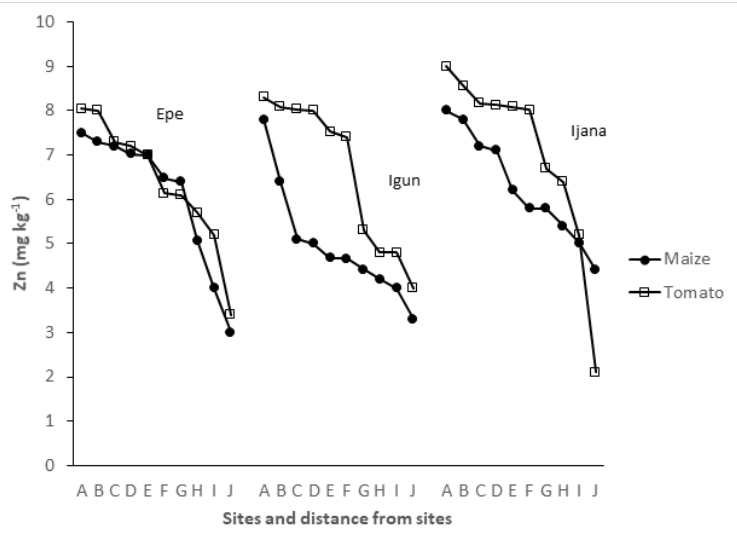
Figure 7: Concentrations of Zn in maize and tomato crops at Epe, Igun & Ijana (0 – 900 m) sites. A = 0 m from site; B = 100 m from site; C = 200 m from site; D = 300 m from site; E = 400 m from site; F = 500 m from site; G = 600 m from site; H = 700 m from site; I = 800 m from site; J = 900 m from